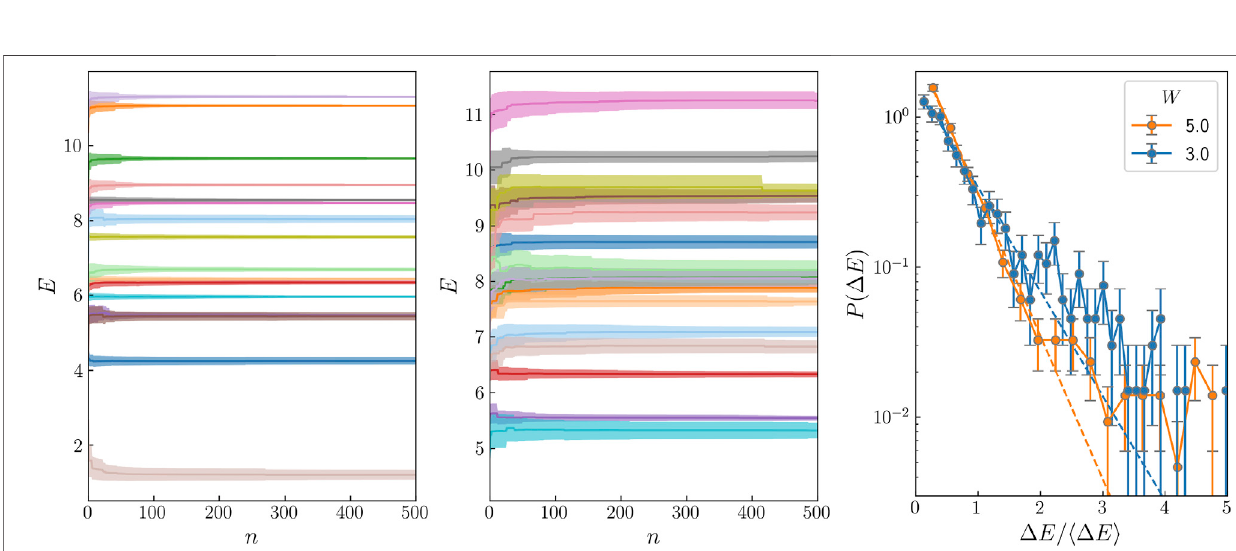
FIGURE 2| Energy asa function ofthe number of displacement transformations performed forseveral states for adisorder W (cid:1) 5, panel (A) , and W (cid:1) 3, panel (B) . The width of the shaded area is equal to the standard deviation of the energy. (C) Energy level spacing distribution for W (cid:1) 5 (blue) and 3 (orange) and L (cid:1) 20.